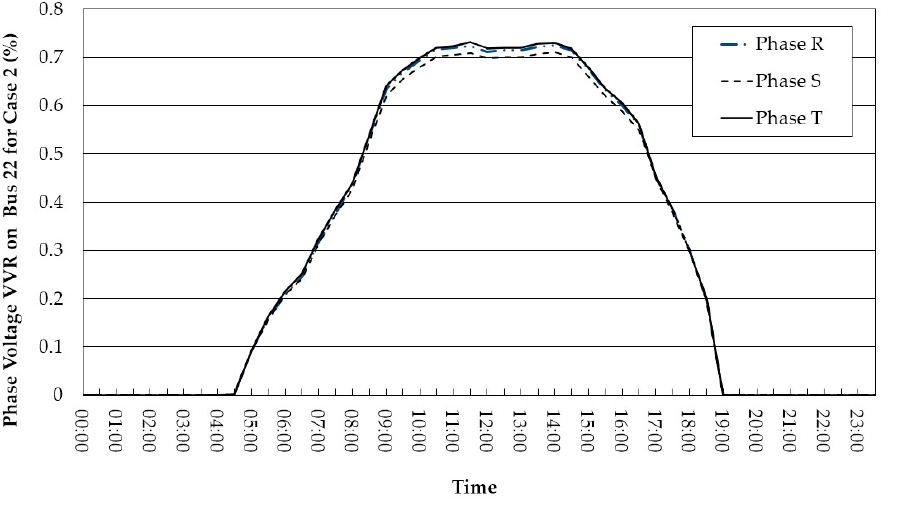
Figure 20. Three-phase VVR variation on Bus 1 for Case 3. Figure 21. Three-phase VVR variation on Bus 22 for Case 3.